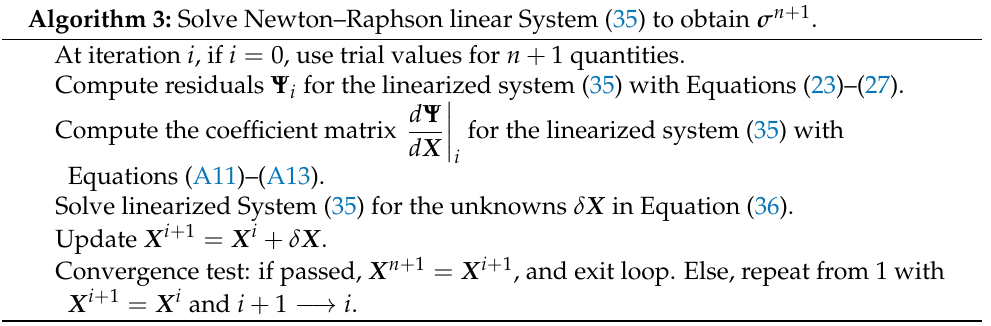
Algorithm 3: Solve Newton–Raphson linear System (35) to obtain σ n + 1